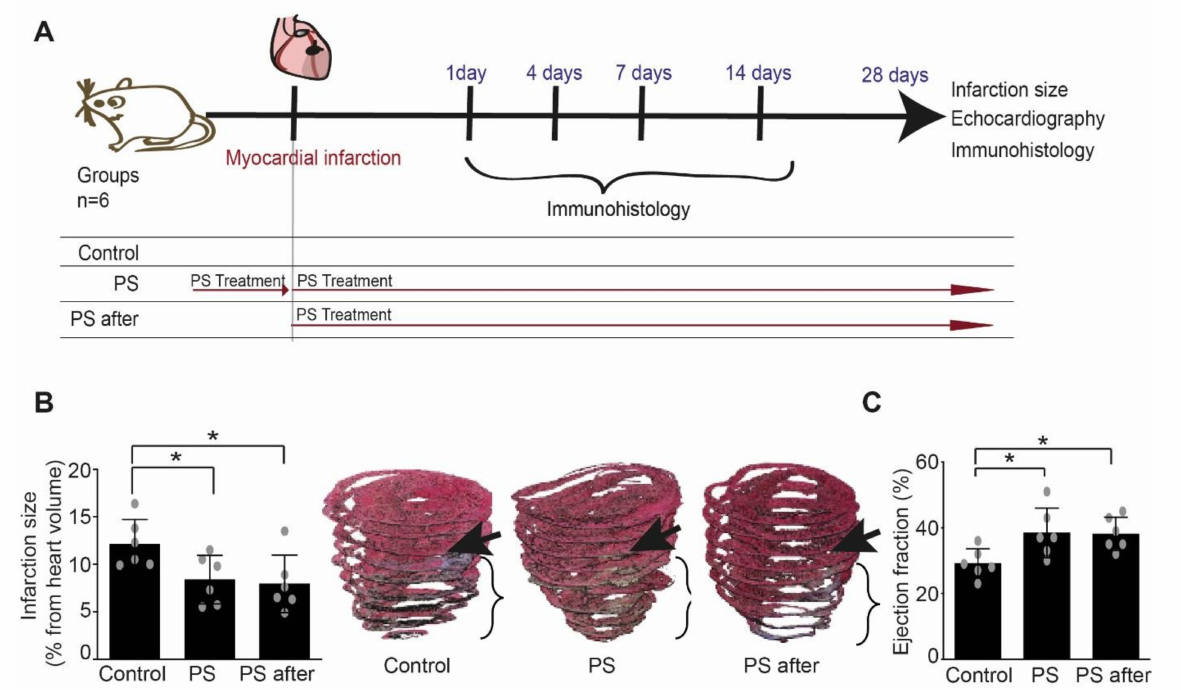
Figure 3. Phosphatidylserine supplementation reduced infarct size and prevented adverse post-infarct LV remodeling.